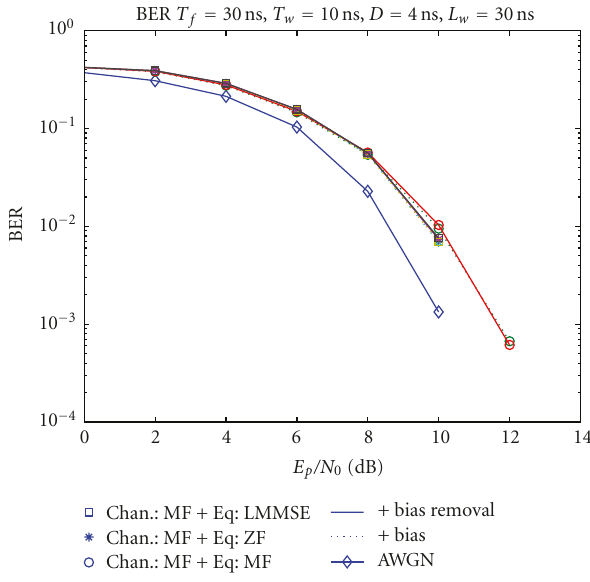
Figure 11: BER performance for